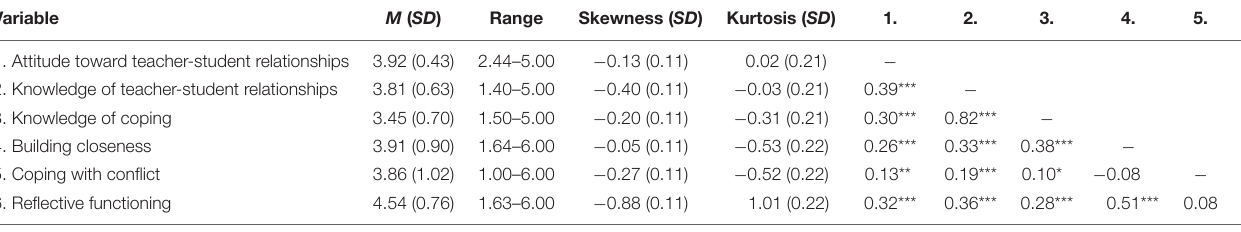
TABLE 9 | Descriptive statistics and correlations between COMMIT subscales. Variable M ( SD ) Range